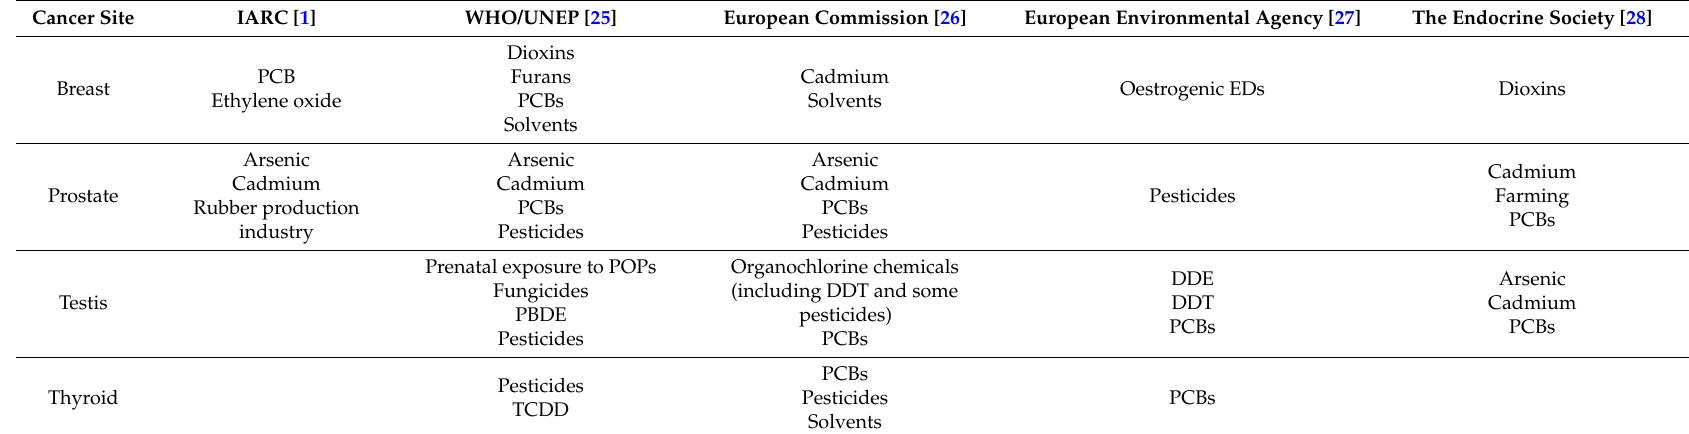
Table 1. Environmental pollutants with endocrine disrupting properties considered to be carcinogenic by scientific institutions/advisory committees for the tumours